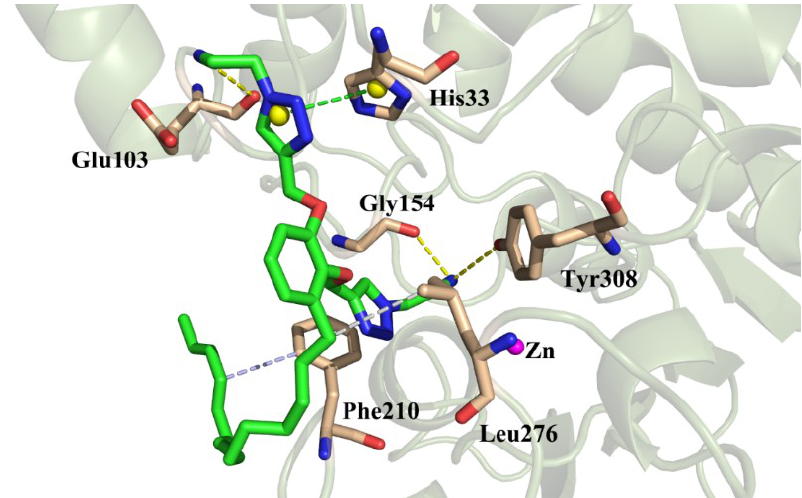
Figure 3. Compound 4 ’s molecular docking modeling in the active site of histone deacetylase (HDAC)2. As seen in the picture, the green stick represents the ligands, the wheat stick stands for the key residues, the cartoon denotes the protein smudge color, and the yellow dotted line indicates a hydrogen bond.